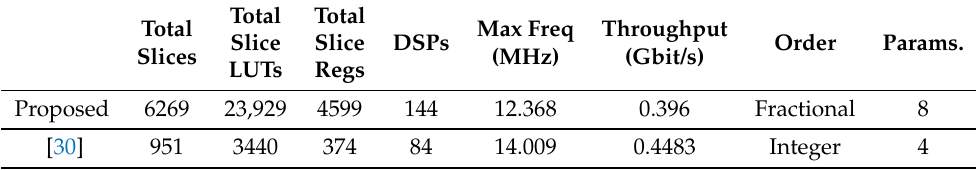
Figure 8. The FPGA experimental results: xz projection. Table 5. The FPGA resources summary of the fractional memristive